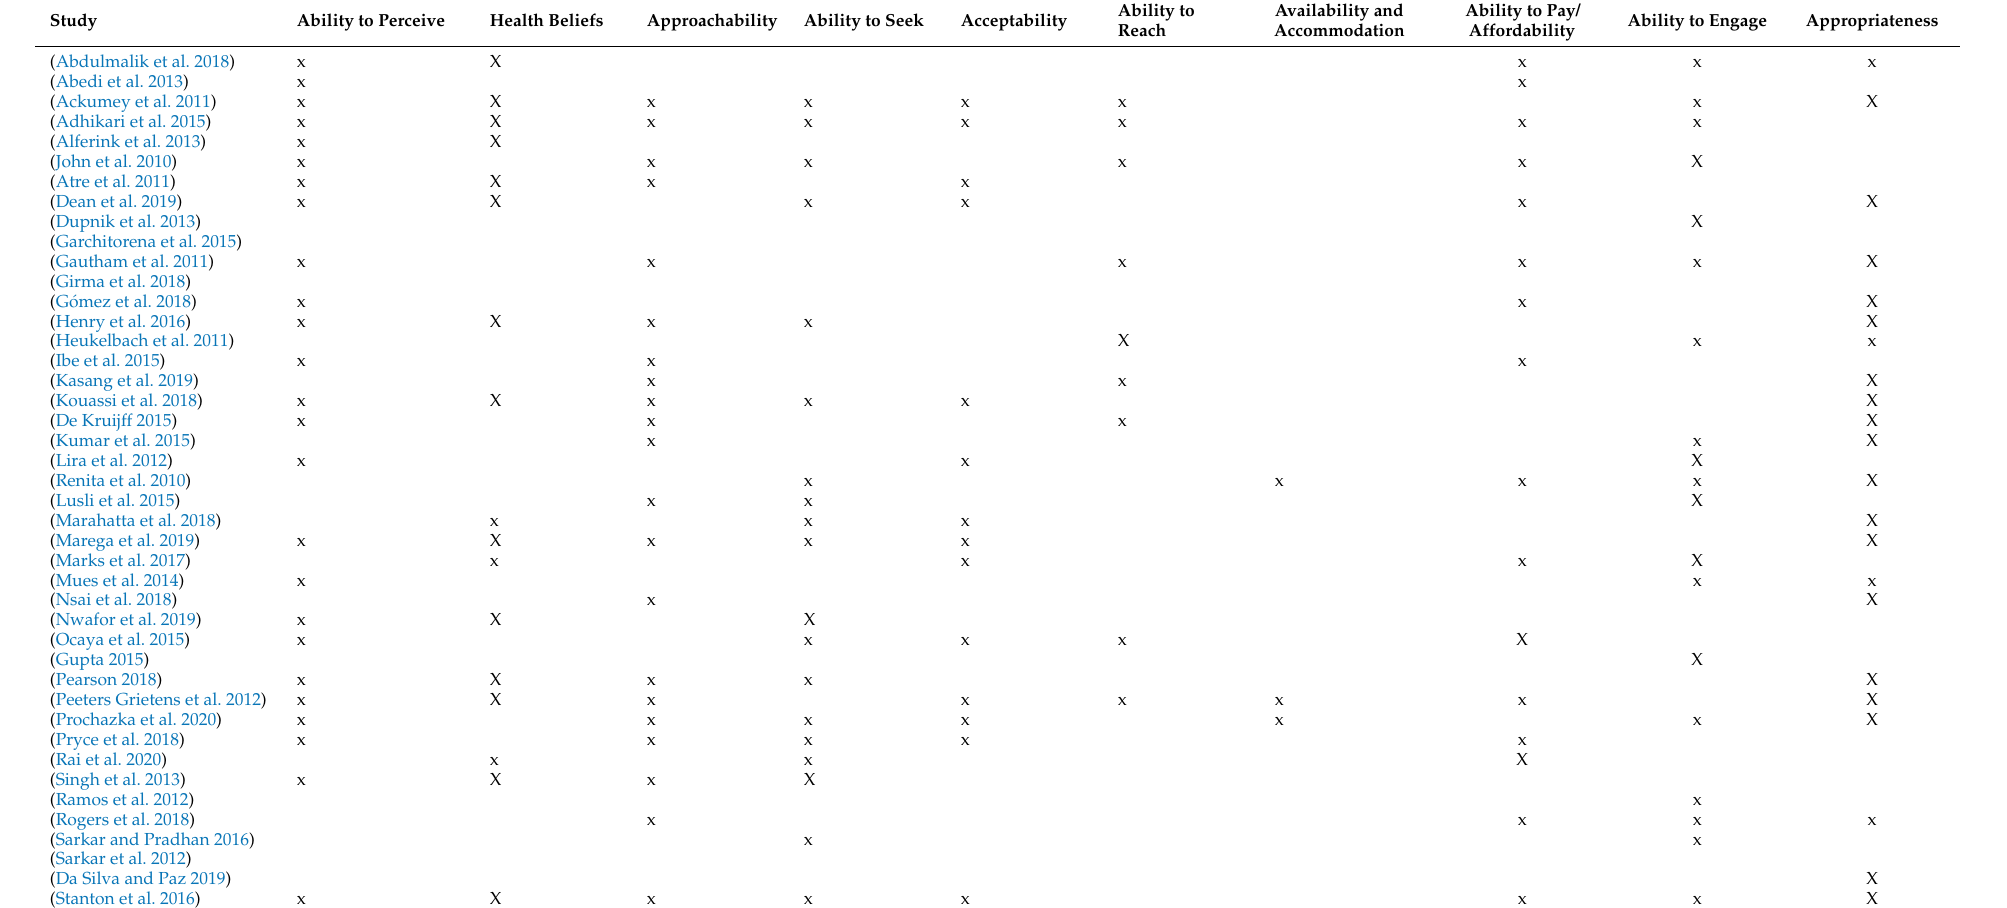
Table 3. Supply and demand aspects of health seeking across the patient pathway described within included